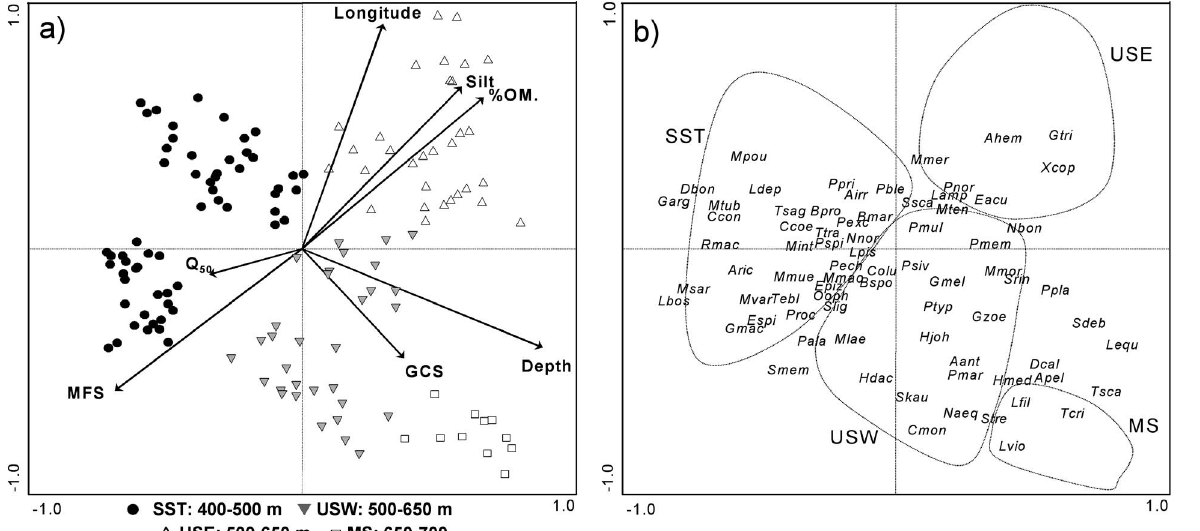
Fig . 3. – RDA biplots. a) Environmental variables versus hauls. Symbols represent cluster groups of hauls: SST, shelf-slope transition; USW, western upper slope; USE, eastern upper slope; MS, middle slope. Q , median particle diameter; S , sorting coefficient; GCS, weight percentage 50 0 of gravel and coarse sands (>500 μm); MFS= weight percentage of medium, fine and very fine sands (63-500 μm); Silt, percentage weight of silt (<63 μm); %OM, weight percentage of organic matter. b) Species. Areas represent groups of hauls. Species codes figure in Tables 2 and 3.